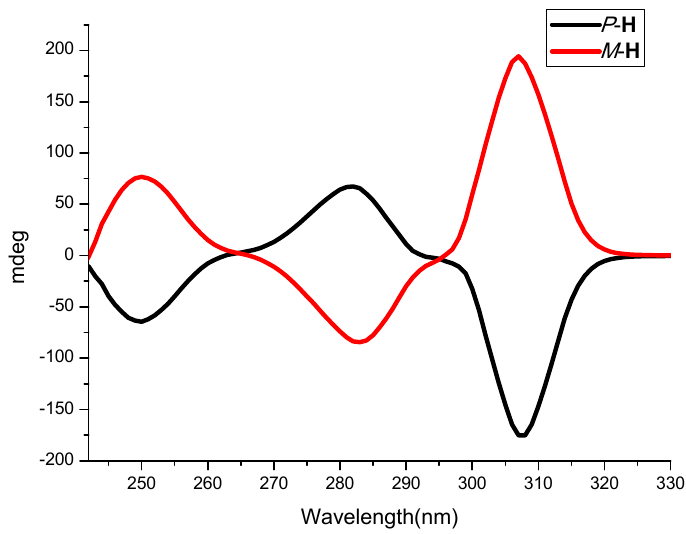
Figure 2. CD spectra of P - H and M - H (CH 2 Cl 2 , c = 2×10 -5 M -1 , T = 298